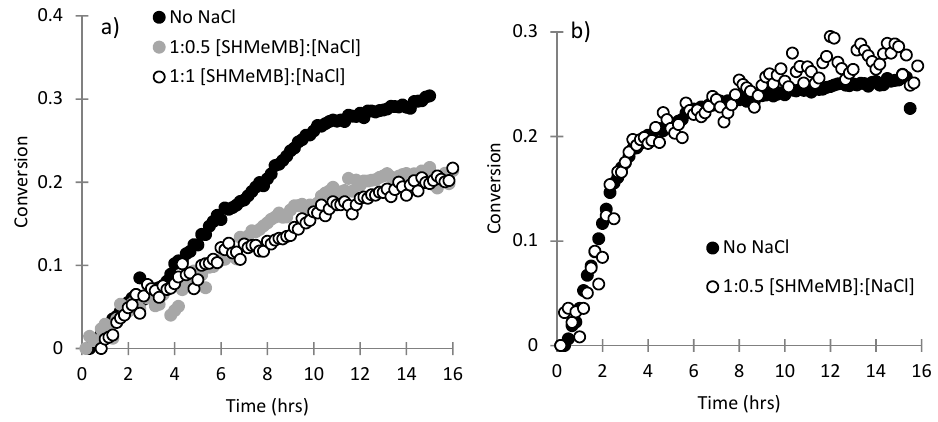
Figure 5. Monomer conversion profiles obtained from homopolymerizations of SHMeMB at 15 wt %